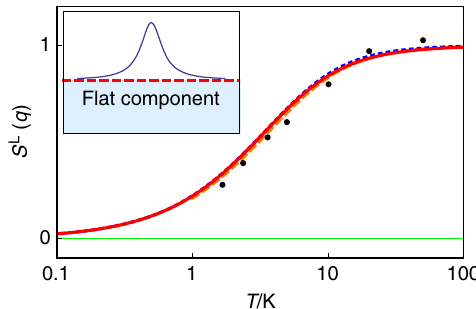
Fig. 5 Experimental indication of the harmonic phase in spin ice. Inset: line shape of the longitudinal scattering function of Ho 2 Ti 2 O 7 , indicating the fl at component beneath a Lorentzian peak. Main fi gure: points are experimental neutron scattering data for the ‘ fl at ’ component of the longitudinal correlation function S L ( q ) of Ho 2 Ti 2 O 7 measured at Q = (0.5, 0.5, 2) vs. temperature, as reported by Fennell et al. 23 , Fig. 4D. The three curves shown on the fi gure (which are almost coincident) correspond to S L ( q ) calculated for the harmonic phase according to the left hand expression of Eq. (13), using the following estimates of the susceptibility χ : (i: red full curve — see Methods) the single tetrahedron-Onsager calculation presented here; (ii: blue short dash curve), theoretical susceptibility for near neighbour spin ice; 30 (iii: orange long dash curve) an analytic approximation to the experimental susceptibility 31 . The experimental neutron data, which is not measured in absolute units, has been scaled, but is consistent with the harmonic phase theory. Experimental random errors are smaller than the points, but systematic errors may be of order 10% — without a much deeper analysis of the experimental systematic errors, it is impossible to assess the signi fi cance of the observed small discrepancies between theory and experiment. What is certain, however, is that the harmonic phase theory (the curves) capture the experimental scattering much more accurately than the low-temperature monopole calculation 33 (lower green line), which predicts zero